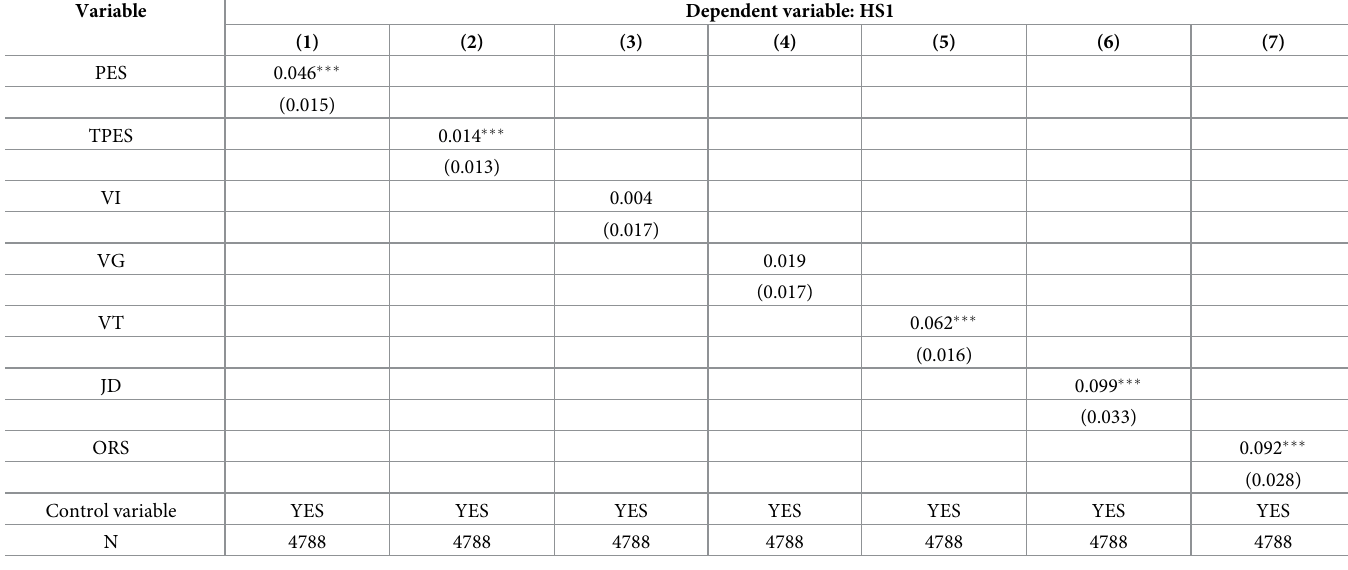
Robust standard errors are in parentheses � , �� and ��� denote significance at the 10%, 5% and 1% level, respectively. Data is from the National Bureau of